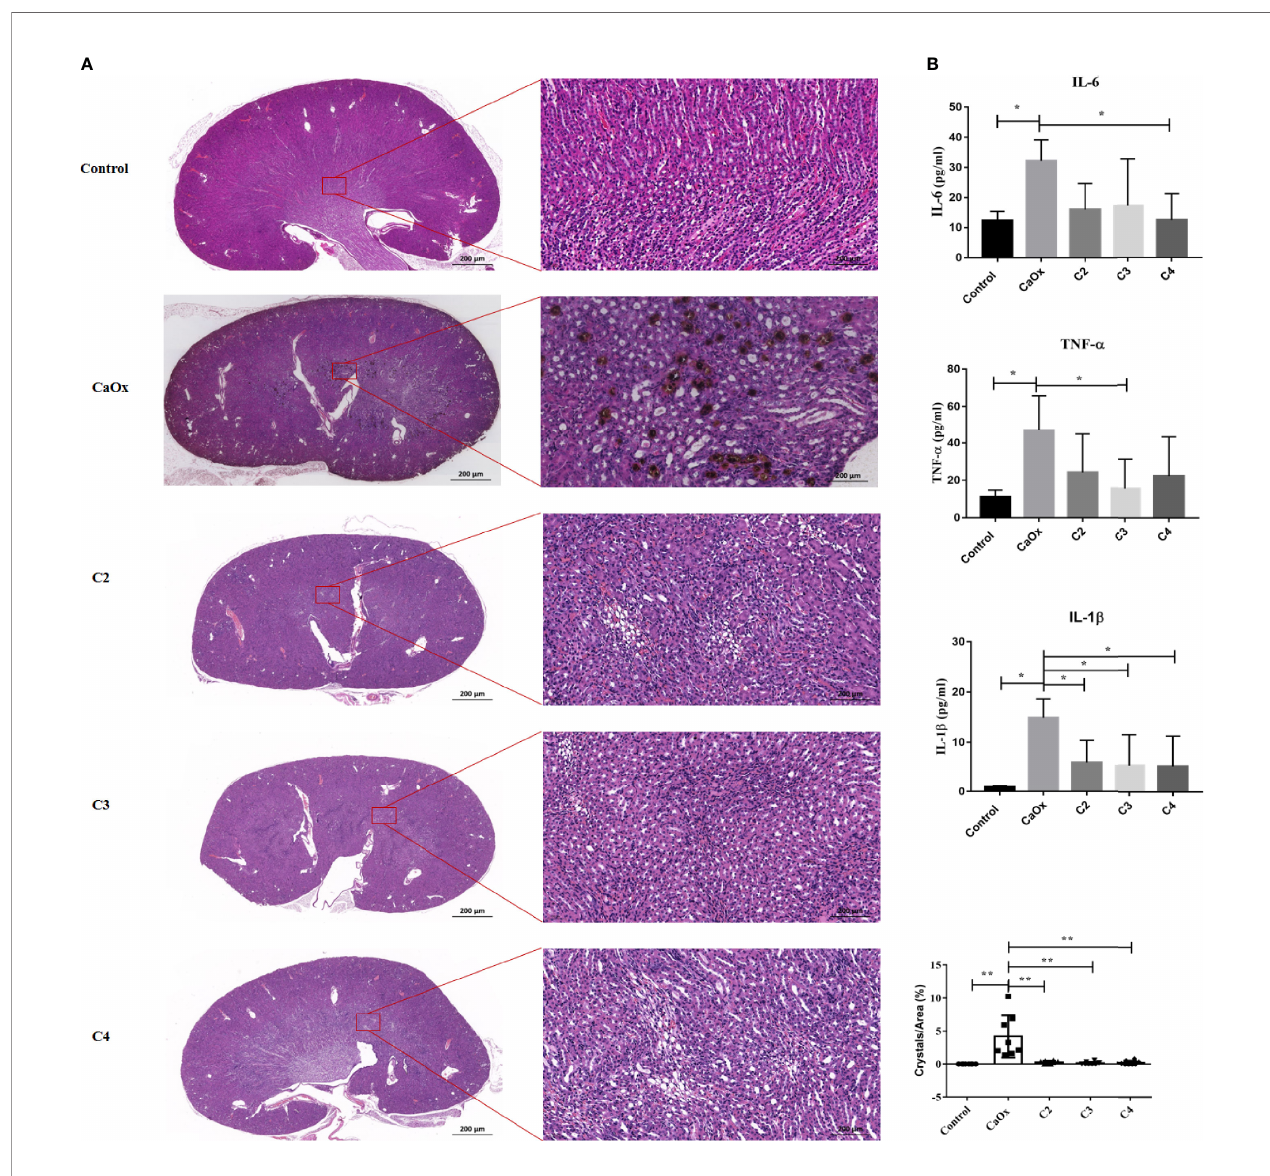
FIGURE 5 | Effect of short chain fatty acid (SCFAs) on renal CaOx crystal formation. (A) Representative images of Von Kossa staining and HE staining in kidney of mice administrated with C2(acetate), C3 (propionate) and C4 (butyrate). (B) The level of serum IL-1 b , IL-6 and TNF- a . Data were shown as mean ± standard deviation. All data were analyzed by one-way ANOVA followed by Tukey ’ s multiple comparisons test among multiple groups. Statistically signi fifi cant was shown as *p < 0.05, **p <